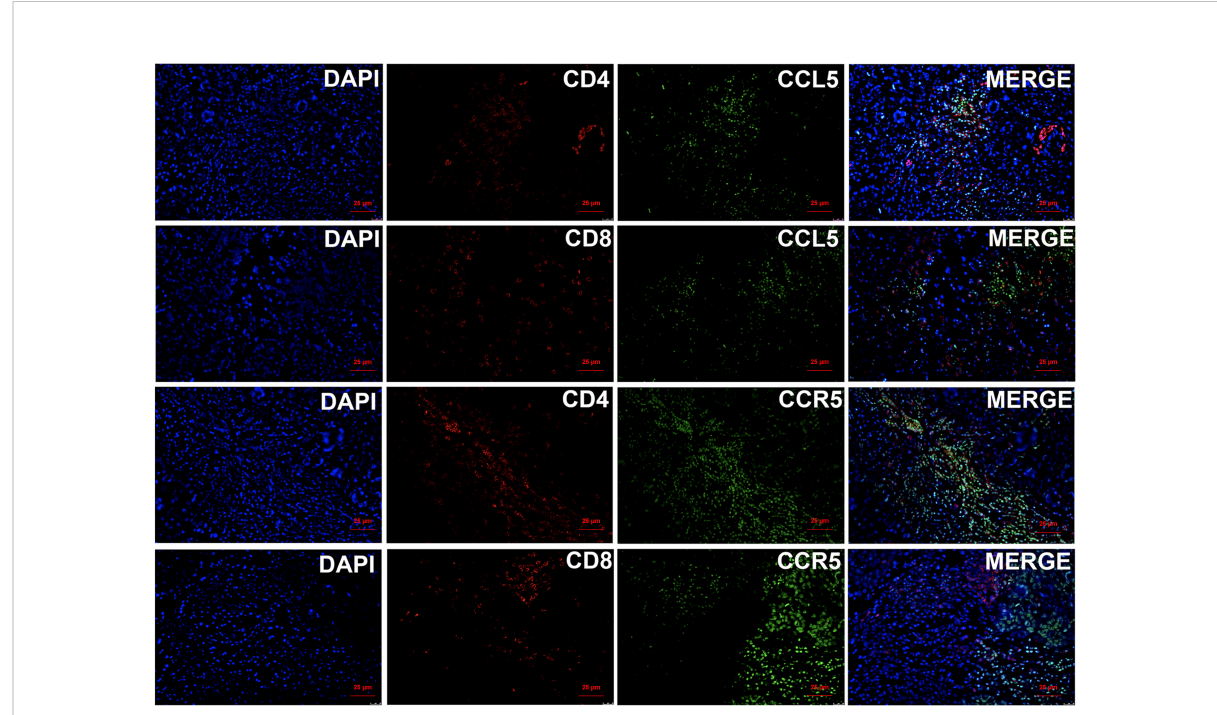
FIGURE 7 Immuno fl uorescence staining of CCL5/CCR5 and CD4/CD8 showed that CCL5/CCR5 is mainly expressed in CD4+ T cells but rarely in CD8+ T